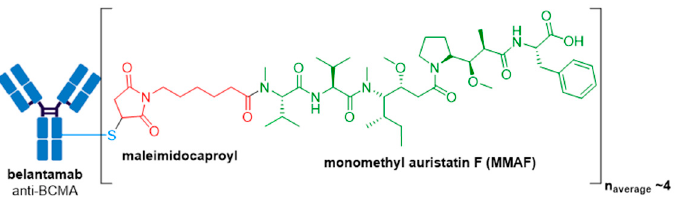
Figure 13. Structure of Blenrep ® (belantamab mafodotin-blmf). The antibody is shown in blue, and chemical structures for linker and payload are in red and green, respectively.